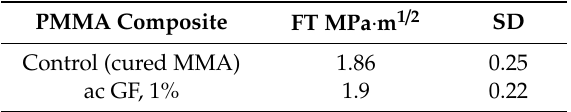
Figure 14. E ff ect of adding filler particles on fracture toughness of the resin. Figure 14. Effect of adding filler particles on fracture toughness of the resin. Table 3. E ff ect of adding filler particles on fracture toughness of the Table 3. Effect of adding filler particles on fracture toughness of the resin.